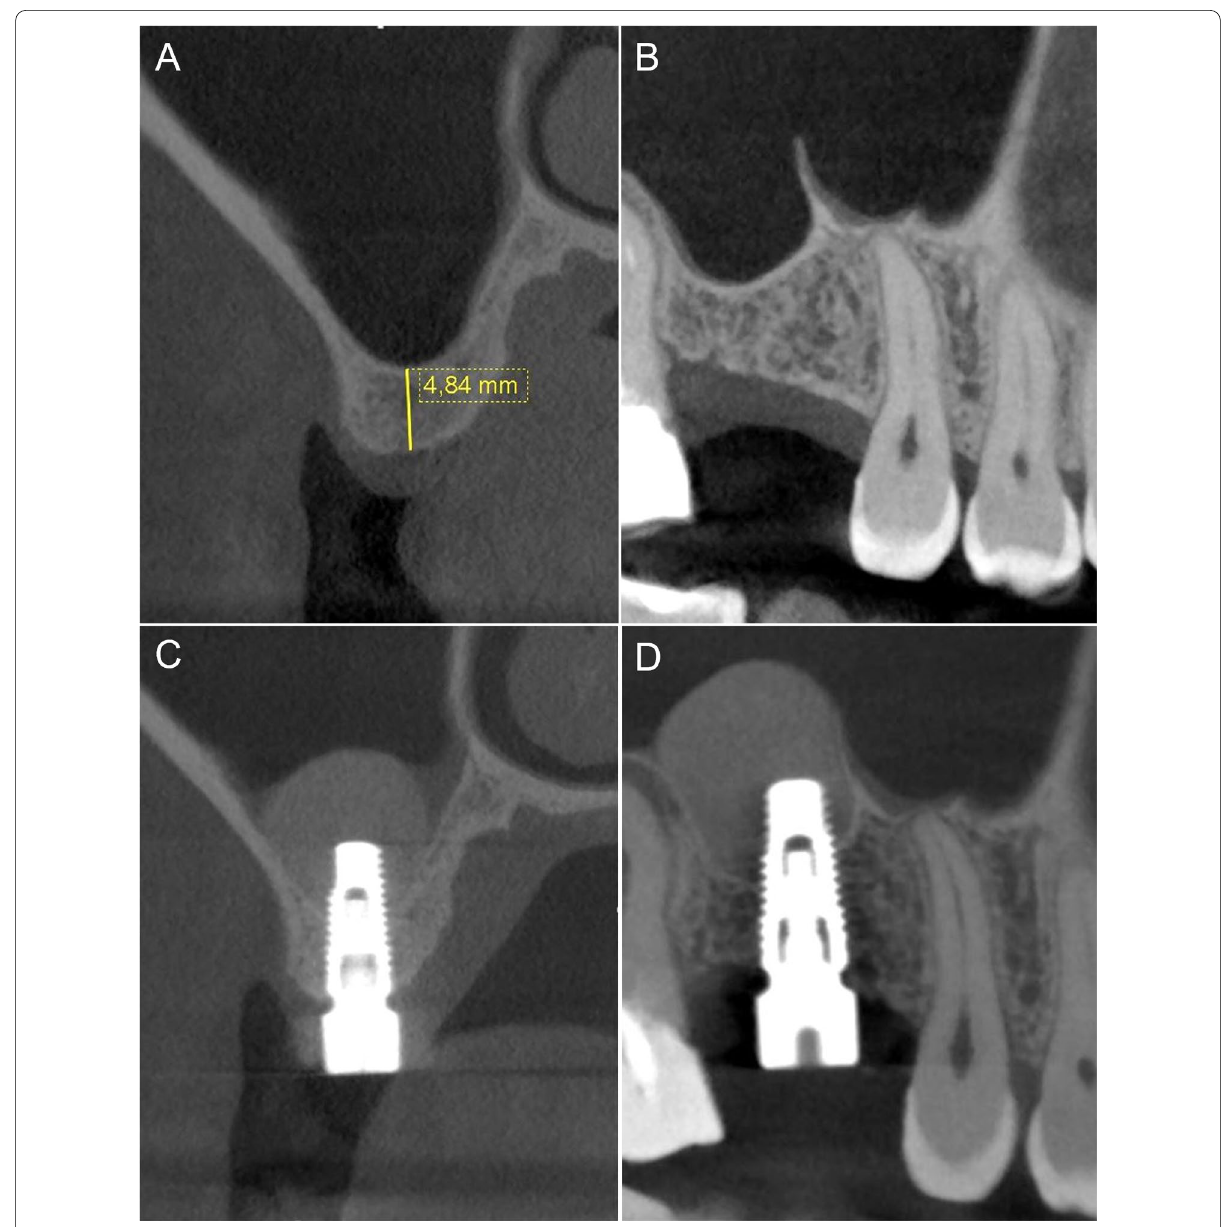
Fig. 4 Pre-surgical CBCT with cross-section showing a narrow sinus anatomy and RBH < 5 mm ( A ) and panorex image highlighting the presence of a sharp Underwood septum ( B ). Post-operative CBCT with cross-section showing abundant amount of gel graft apically to implant apex to counteract the expected shrinkage during the healing phase ( C ) and panorex confirming sinus membrane integrity ( D